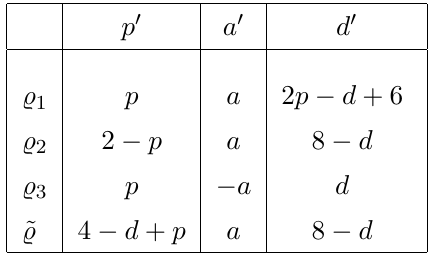
= (cid:28) i (cid:6) i(cid:25) of the coordinates. i